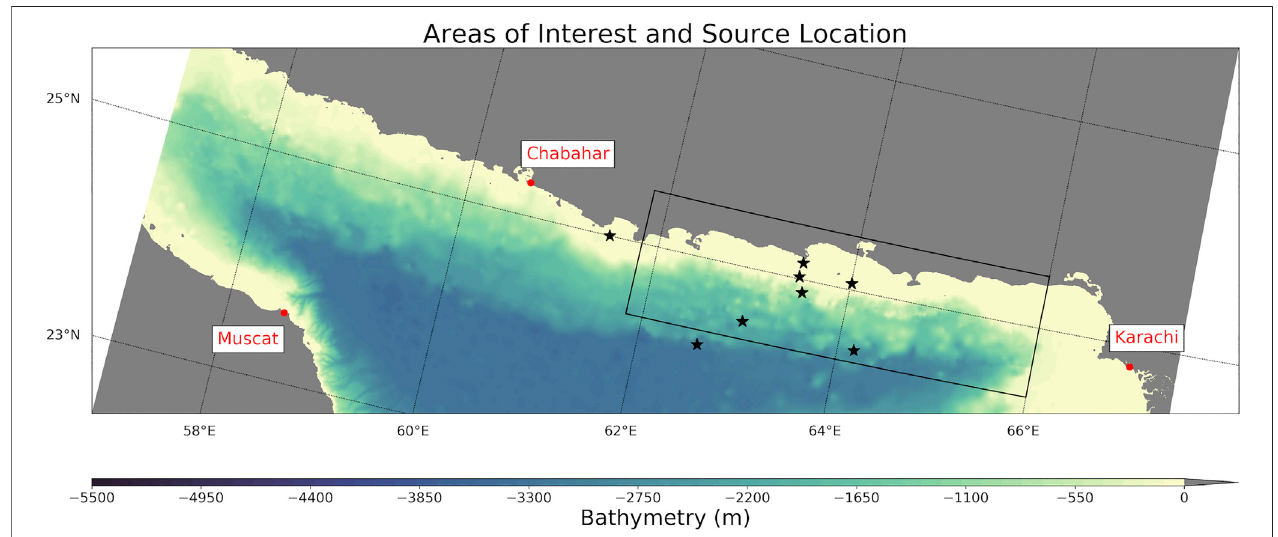
FIGURE 2 | BathymetryoftheMakranregion,withtheareasofinterest:Chabahar,MuscatandKarachiports,highlightedbythereddots.Thelocationsofthe1945earthquake sources from the literature are marked with the black stars. The eastern section of the Makran subduction zone (MSZ) considered in this study is bounded by the black box